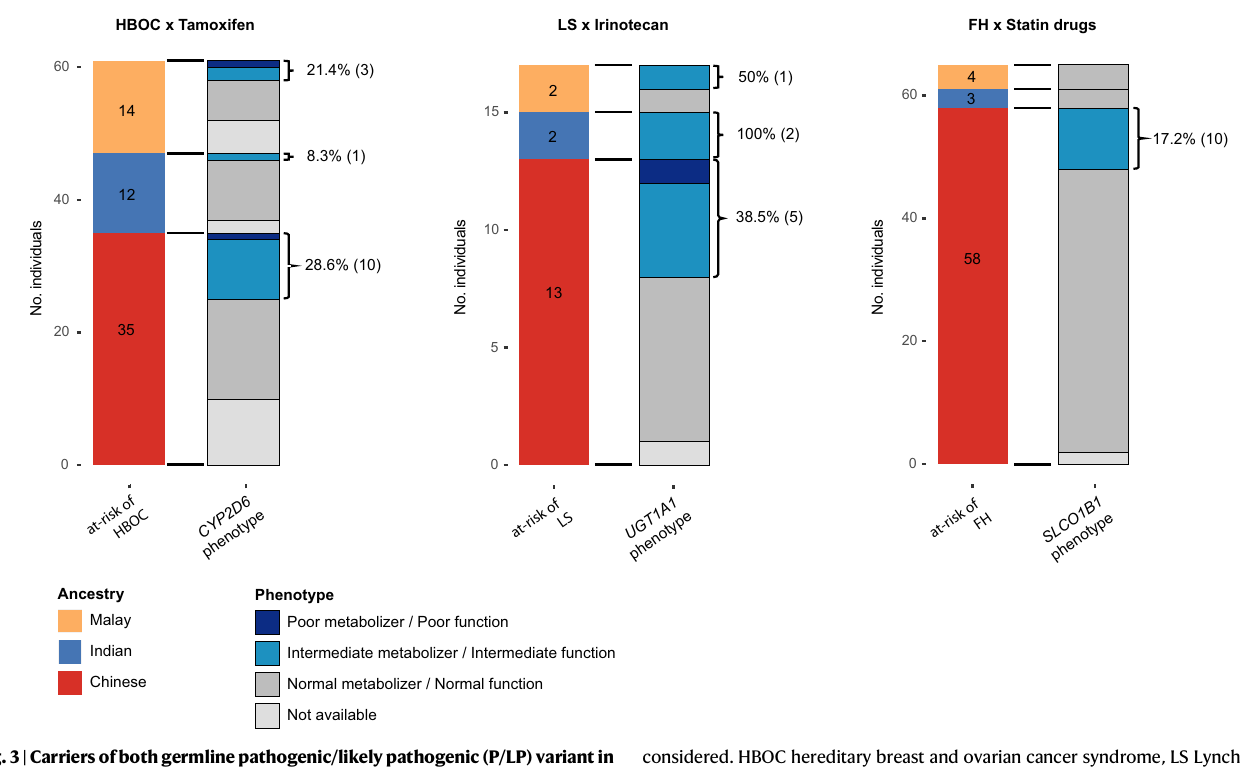
considered. HBOC hereditary breast and ovarian cancer syndrome, LS Lynch syn- drome, FH familial hypercholesterolemia, n number of germline P/LP variant carriers for the indicated CDC Tier 1 genetic conditions among 9051